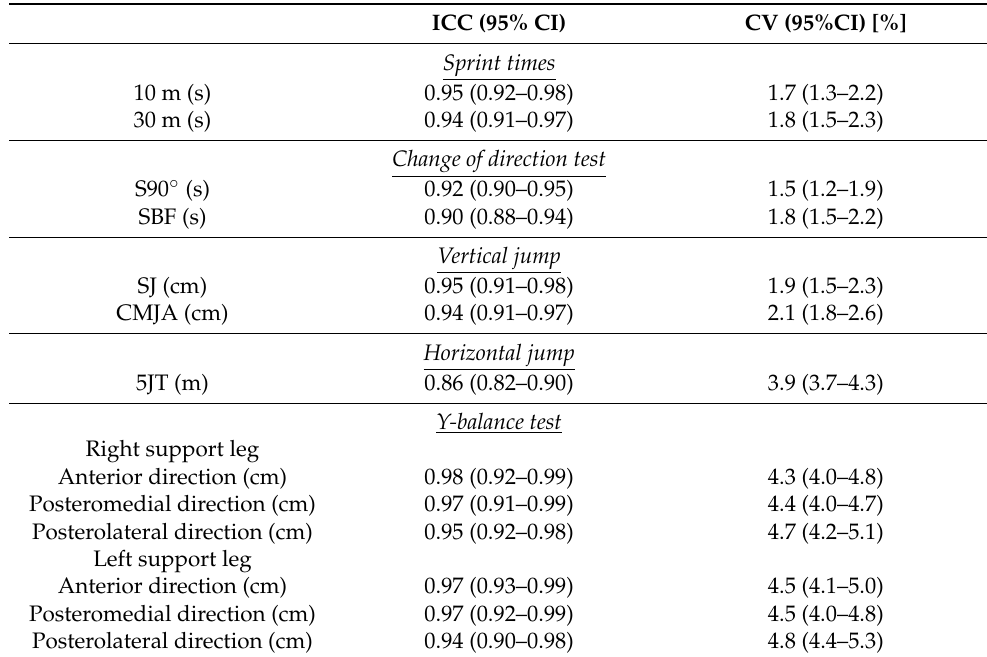
Table 3. Interclass correlation coefficient (ICC, 95% confidence intervals (95% CI)) and coefficient of variation (CV) showing excellent reliability for all performance parameters.